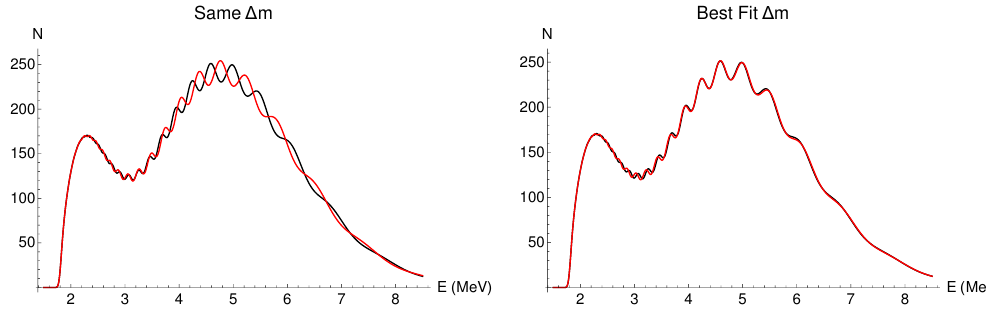
Figure 1 . Expected spectra for normal and inverted hierarchy at 53 km from the source. Left panel: same value of (cid:1) m 2 used for both hierarchy. Right panel: for inverted hierarchy, (cid:1) m 2 32 shifted by (cid:24) 1 : 5 (cid:27)